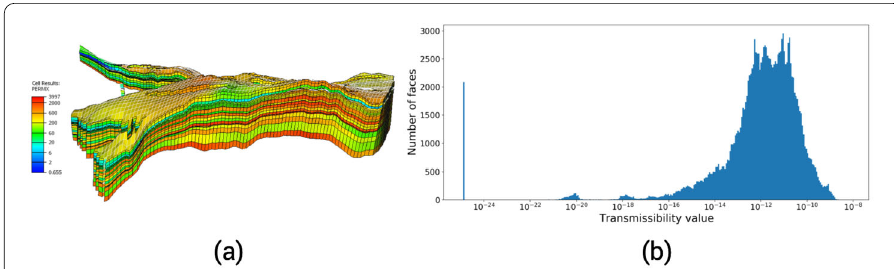
Figure 3 Permeability distribution ( a ) in the x direction of the Norne grid. A histogram plot ( b ) of the transmissibility associated with cell interfaces from the Norne reservoir simulation case. The spike in the left end of the plot represents transmissibilities with value 0